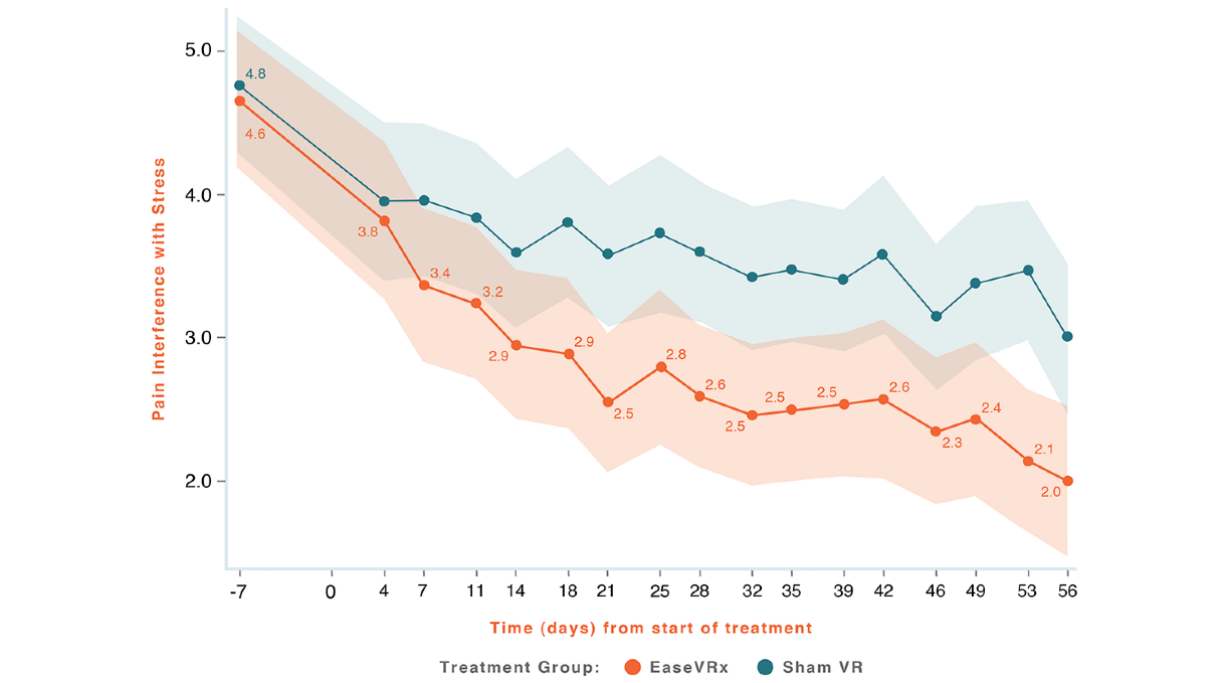
Figure 8. Pain-Related Interference with